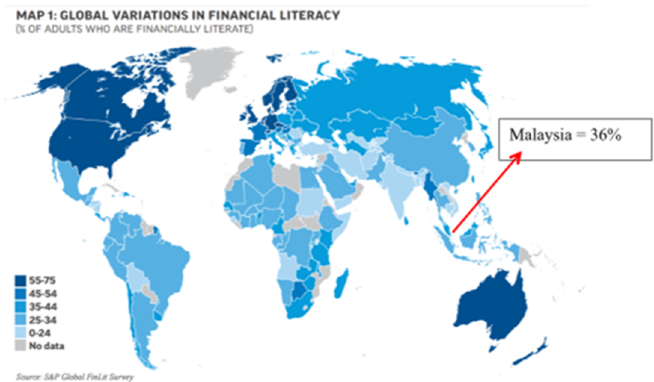
Figure 1. Global Variations in Financial Literacy by Klapper et al [2].